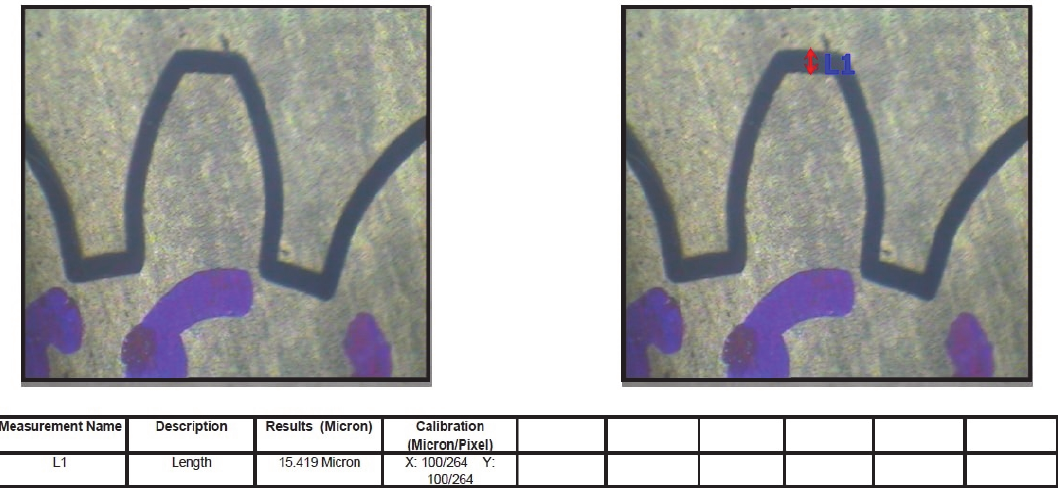
Fig. 2. Work-piece observed under optical microscope at 20X zoom